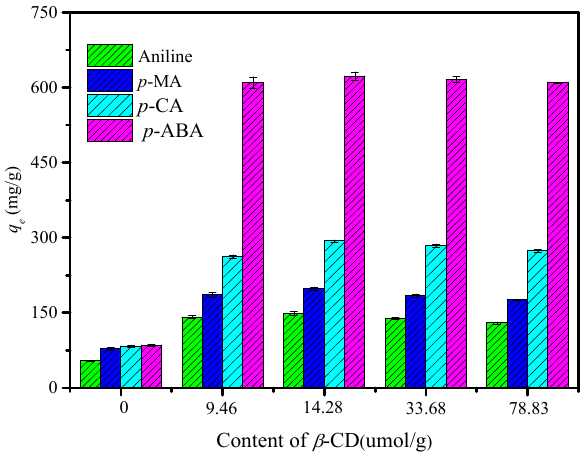
Figure 5. Effect of the amounts of β -CD on the aniline adsorption of the CDM-HCP.